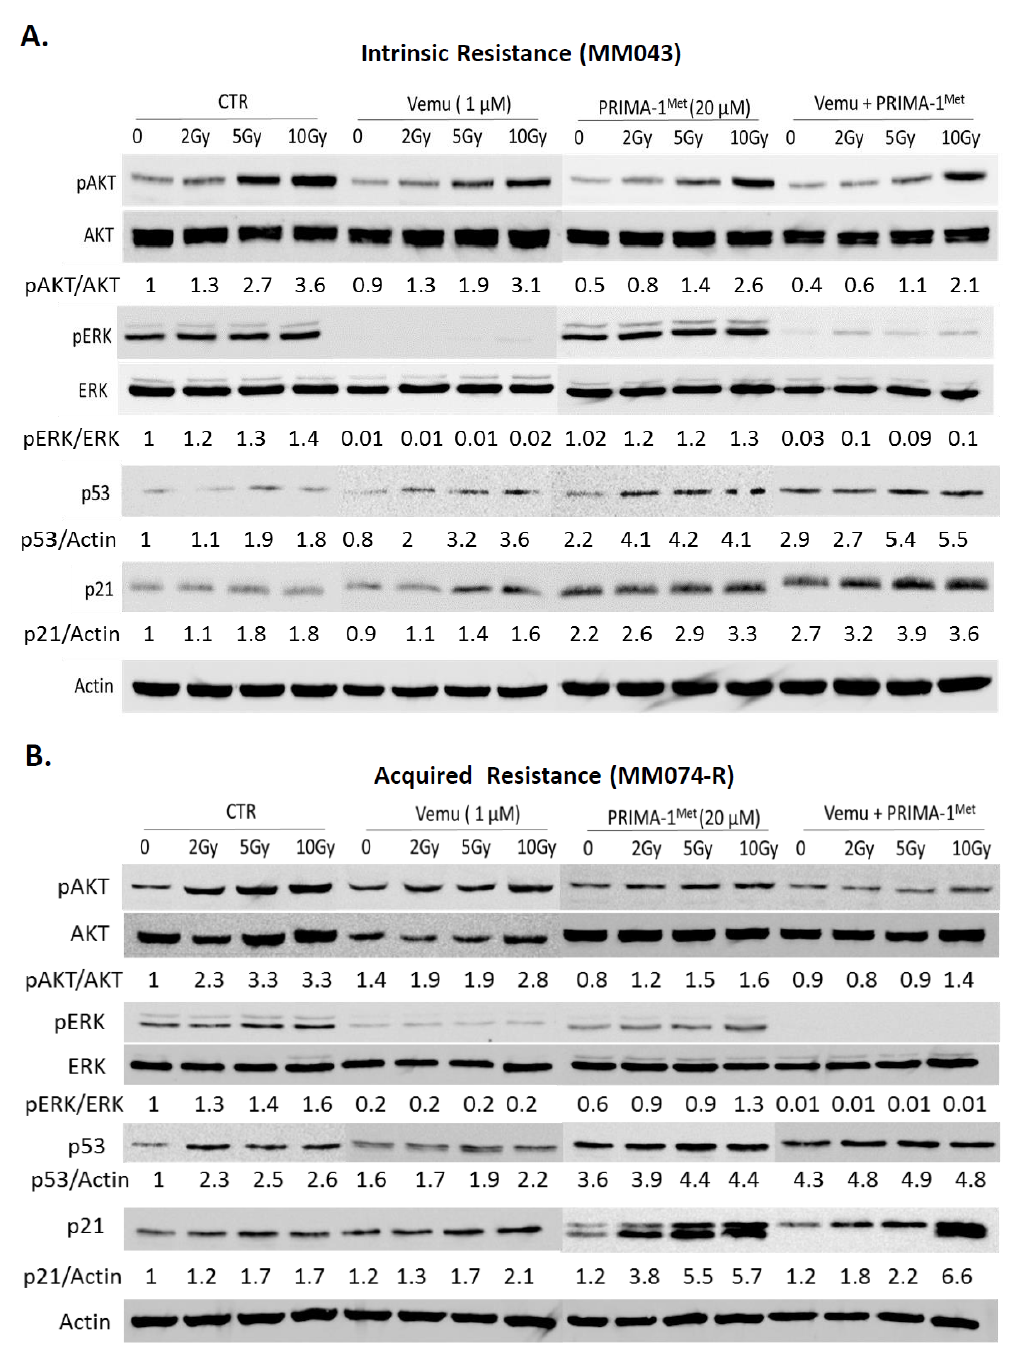
Figure 3. Mitogen-activated protein kinase (MAPK) kinase and PI3K pathways stimulation confers resistance to radiotherapy (RT) in BRAF mutant melanoma cells in vitro. E ff ect of RT with 2 Gy, 5 Gy, and 10 Gy in combination with 1 µ M of vemurafenib and / or 20 µ M of PRIMA-1 Met on the PI3K / AKT, MAPK, and p53 / p21 pathways. ( A ) Cells with intrinsic resistance to vemurafenib (MM043) and ( B ) MM074 ‐ R with acquired resistance to vemurafenib. β‐ actin was used as loading control.